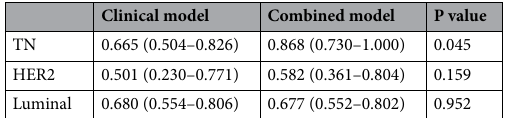
Table 5. AUC (area under the receiver operating characteristic curve) values of the clinical and combined model in the validation cohort. The 95% confidence intervals of the AUCs are shown in parentheses. TN triple- negative.